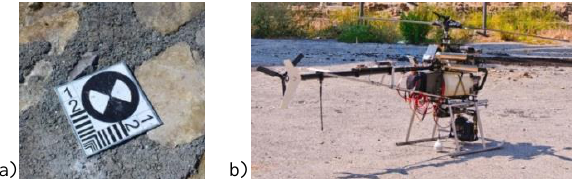
Figure 2. Photogrammetric marker with black and white line pairs corresponding to three different spatial resolution (a). The employed UAV for the photogrammetric aerial survey